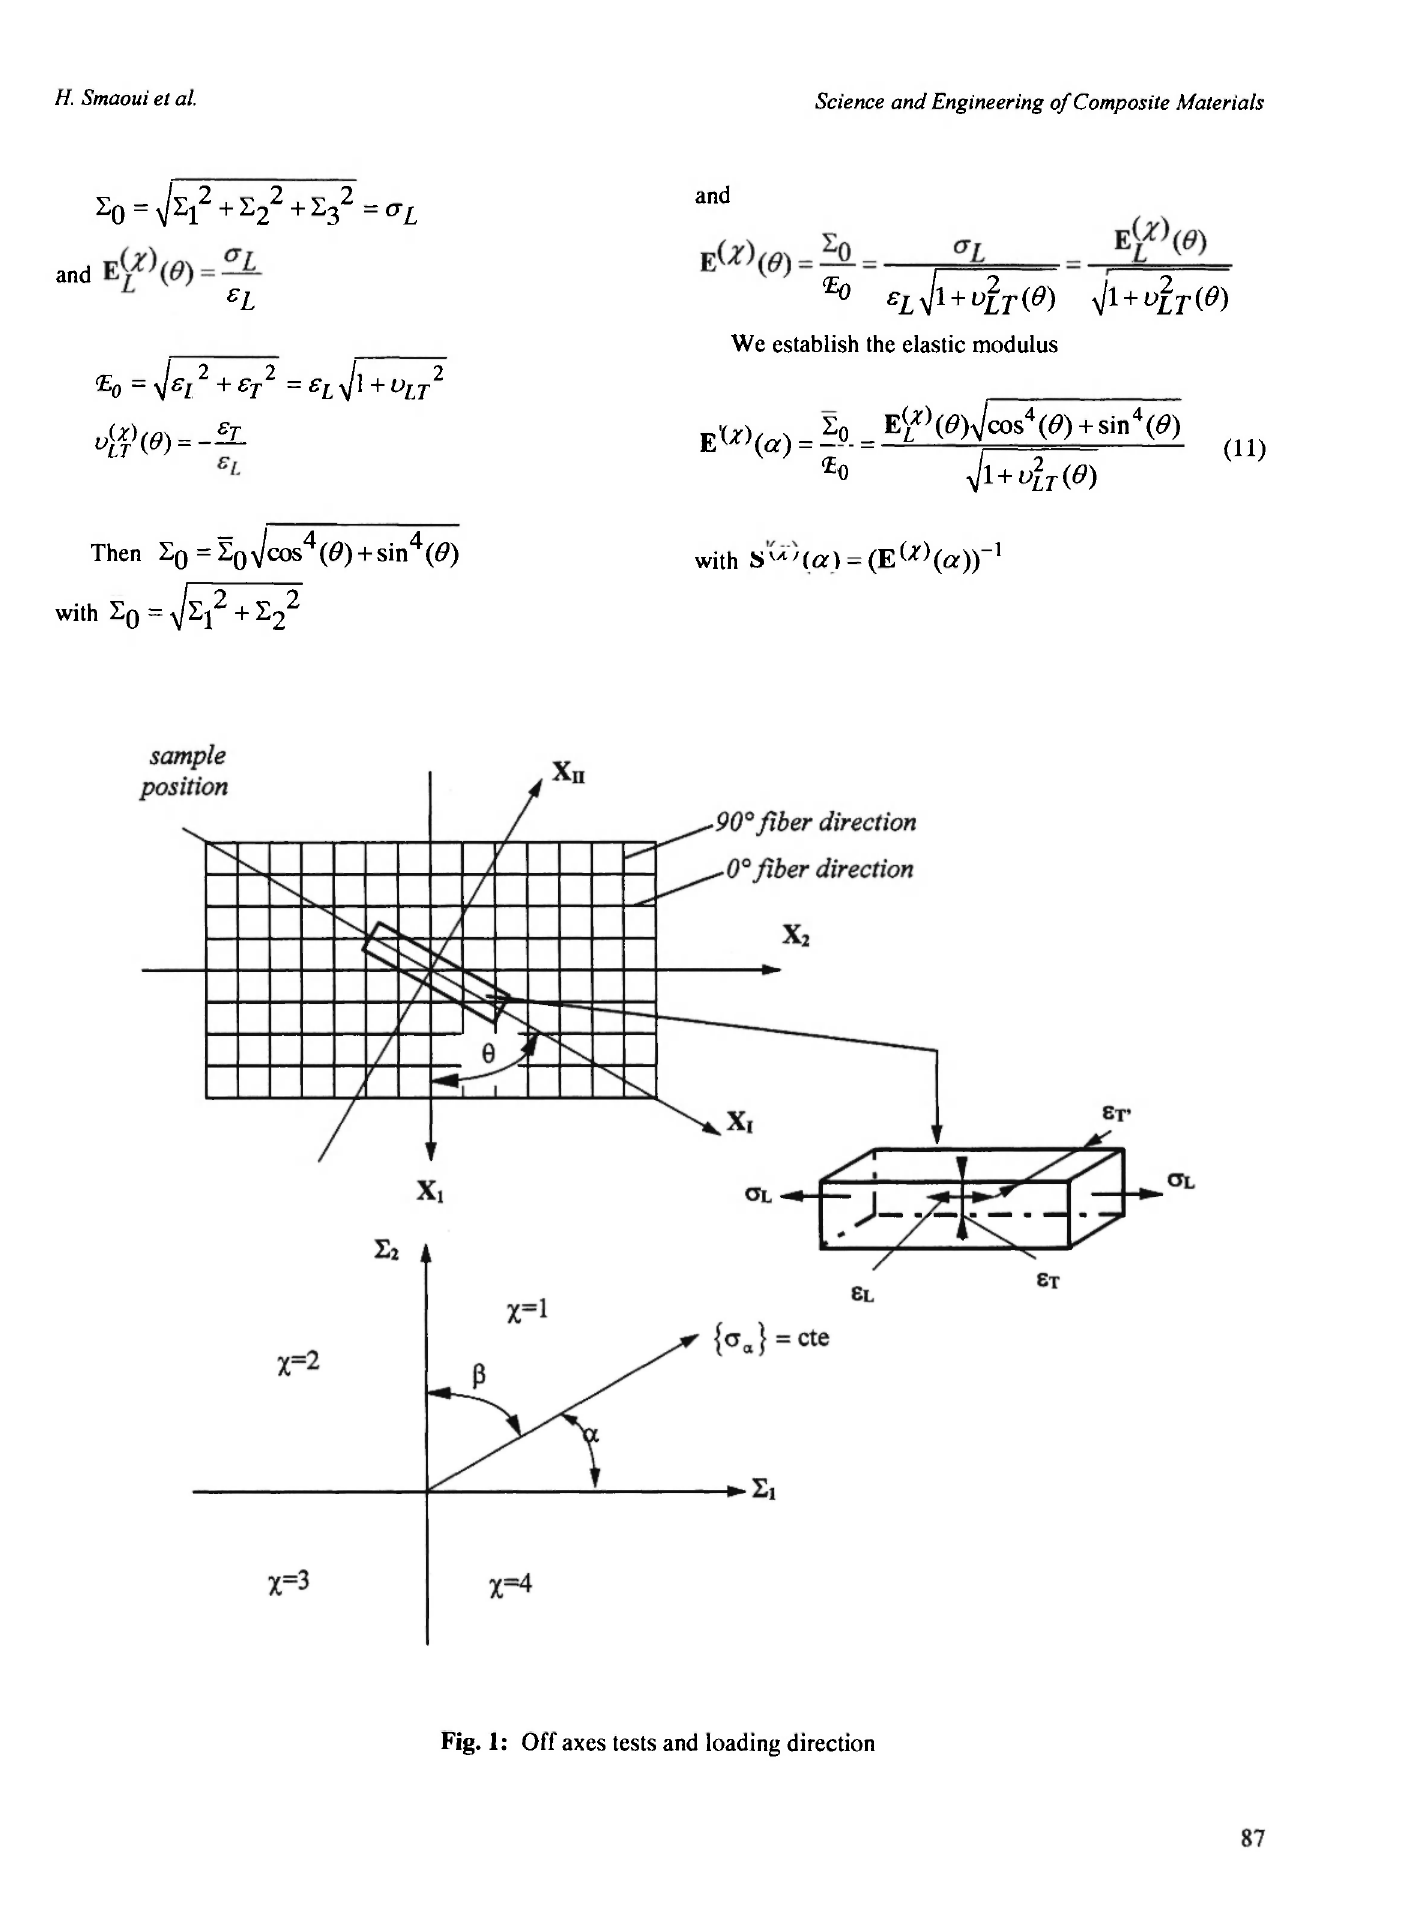
Fig. 1: Off axes tests and loading